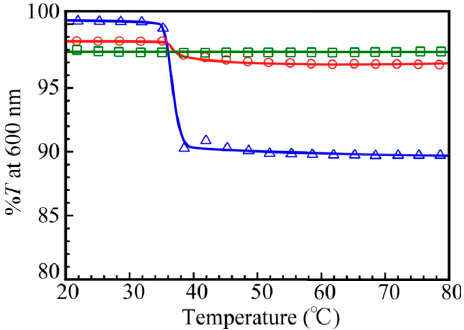
Figure 12. Percent transmittance (% T ) at 600 nm for 0.1 M NaCl aqueous solutions of PNaSS 58 – b – PNIPAM 115 ( ) and a mixture of PNaSS 58 – b –PAA 125 and PNaSS 58 – b –PNIPAM 115 at pH 3 ( □ ) and pH 10 ( ) as a function of solution temperature.